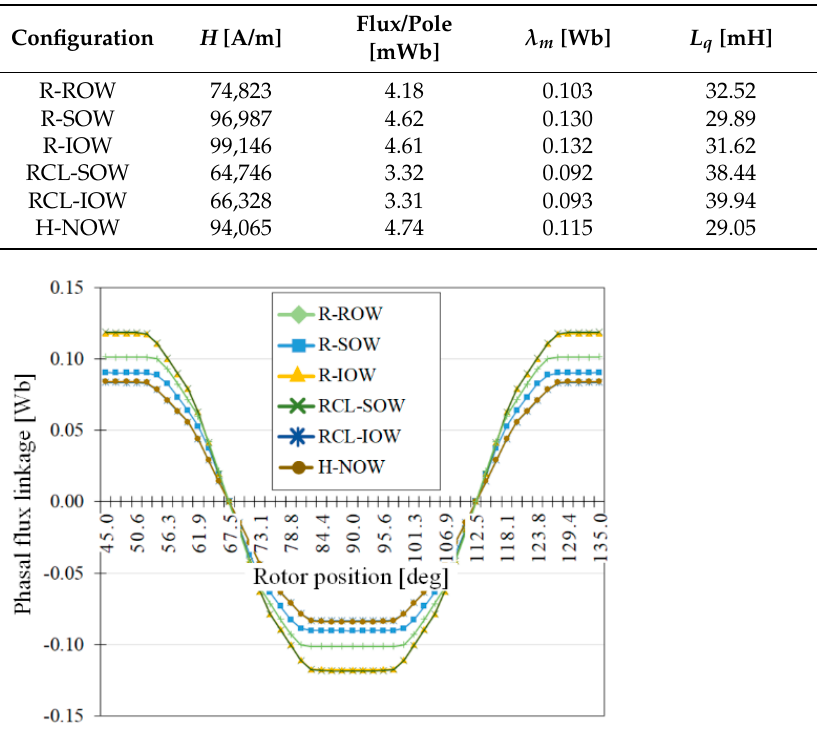
Table 3. Electromagnetic characteristics of the considered PM arrangements for a current density of 6 A/mm 2 .